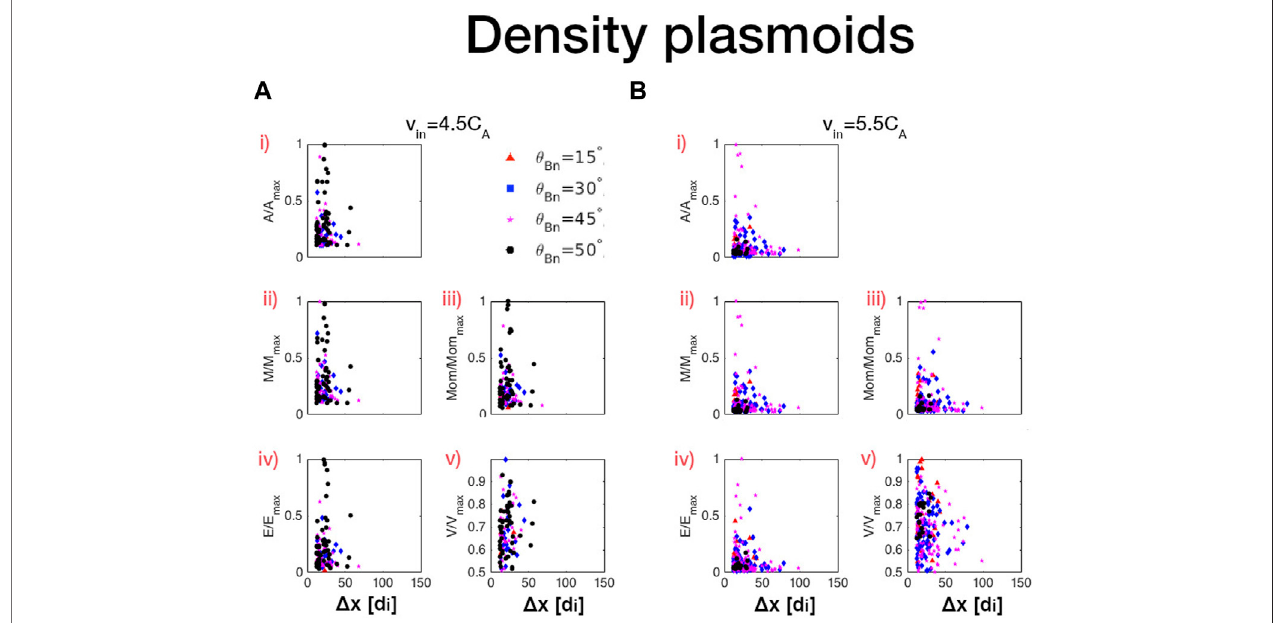
FIGURE 9 | Scatter plots of properties of density plasmoids as a function of their distance from the shock. The format is the same as in Figure 7 except that runs with V in = 3.3 C A are missing since no density plasmoids were formed in